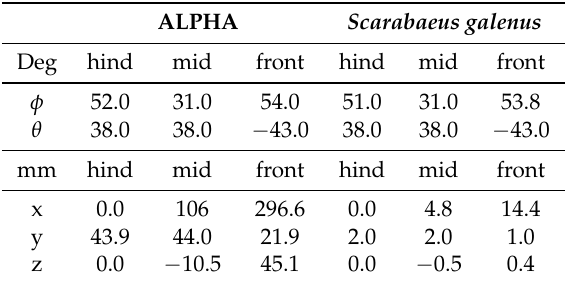
Table 1. Leg configuration of ALPHA and S. galenus . Dimensions are specified in degrees and mm. The scaling factor of [22:1] between the ALPHA and S. galenus is noticeable in the